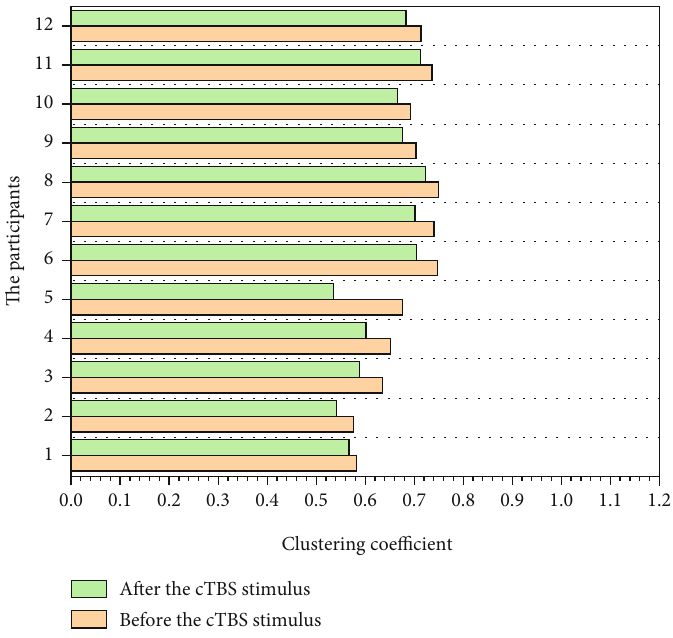
Figure 6: Network clustering coe ffi cient before and after cTBS